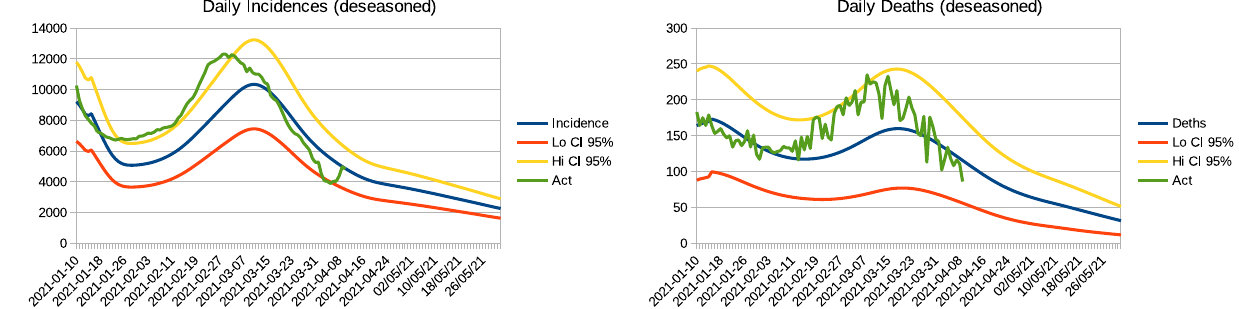
Figure 3. Model F calibration. Left panel: daily detected incidences of COVID-19. Right panel: daily deaths due to COVID-19. Legend: blue line is the mean prediction, while the yellow and red lines delimit the 95% confidence interval. Green curve represents real data.